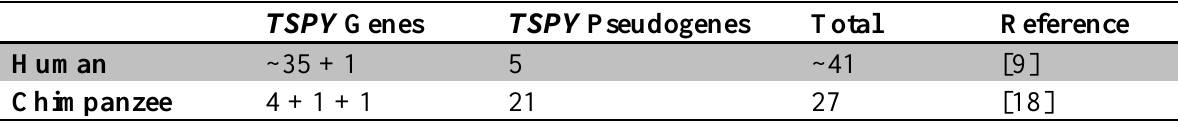
Table 1. Numbers of TSPY gene and pseudogene copies in the human and chimpanzee reference